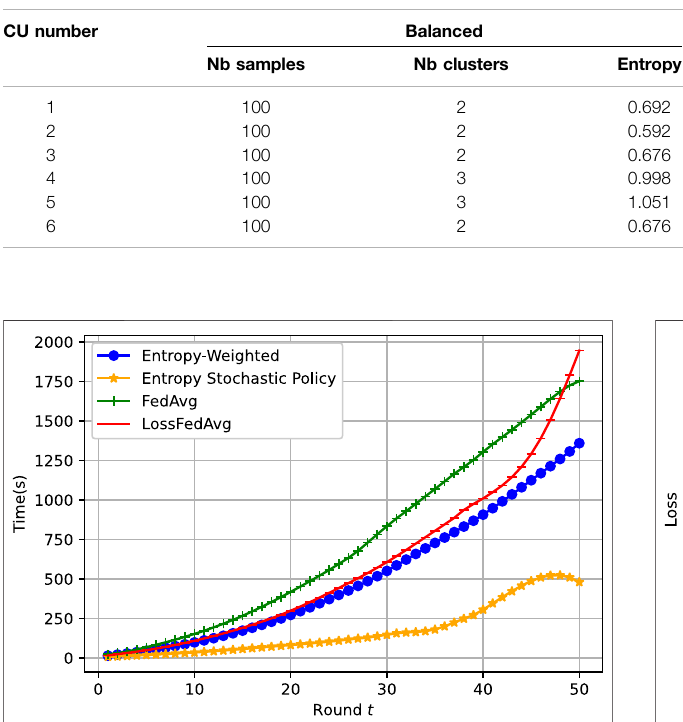
TABLE 3 | Results: Datasets clustering.